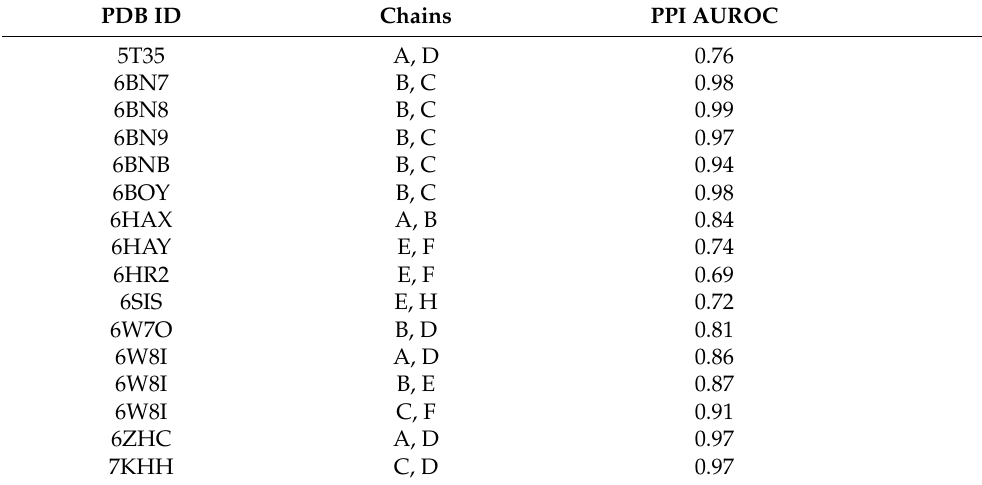
Table A7. AUROC scores for PPI prediction of our model trained on the super-dataset (see Figure 4, panel C). See Tables A8 and A9 for exemplary confusion matrices for the complexes 6BN8 and 6HR2, respectively.